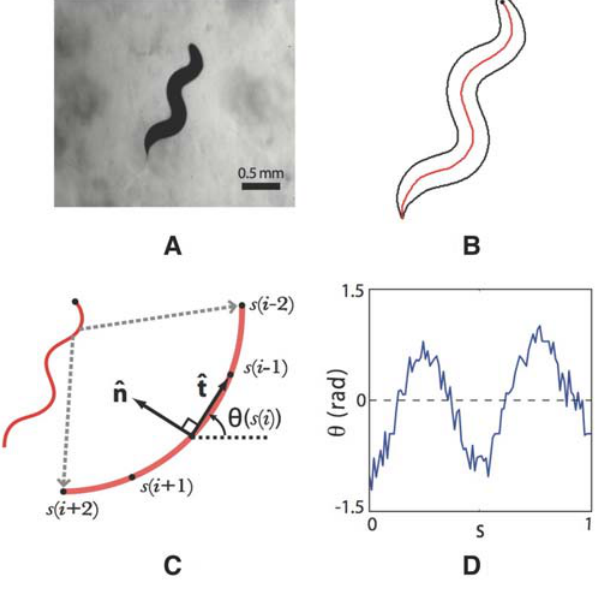
Figure 1. Describing the shapes of worms. (A) Raw image in the tracking microscope. (B) The curve through the center of the body. The black circle marks the head. (C) Distances along the curve (arclength s ) are measured in normalized units, and we define the tangent ^ t ( s ) and normal ^ n ( s ) to the curve at each point. The tangent points in a direction h ( s ), and variations in this angle correspond to the curvature k ( s )= d h ( s )/ ds . (D) All images are rotated so that Æ h æ =0; therefore h ( s ) provides a description of the worm’s shape that is independent of our coordinate system, and intrinsic to the worm itself.